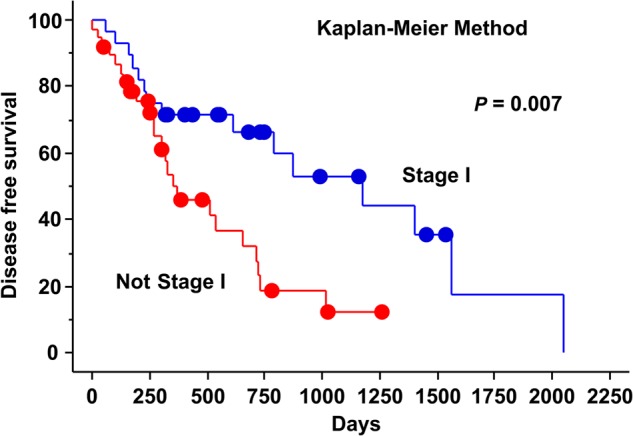
Progression-free survival curves by clinical stage (I vs II–III).